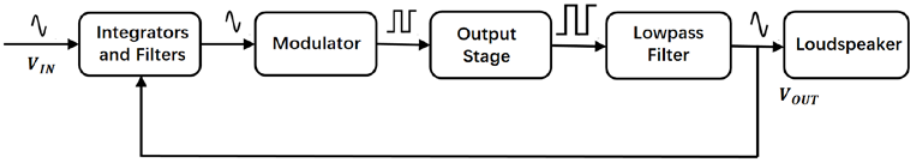
Figure 2. Block diagram of an audio amplifier.